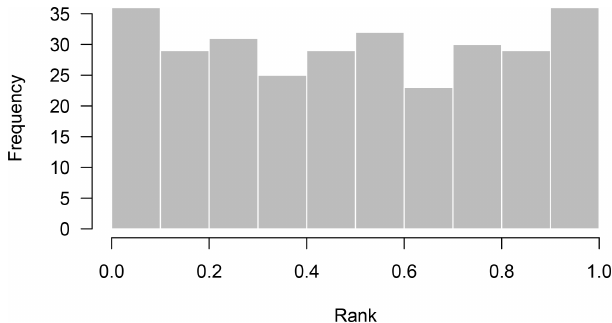
Figure 7. Rank histogram of leave-one-out predictions. For each prediction of a held-out ensemble member, we sample 1000 points from the Gaussian prediction distribution and then record where the true held-out ensemble member ranks in that distribution. We plot a histogram of the ranks for all 300 ensemble members. A uniform distribution of ranks indicates that uncertainty estimates of the em- ulator are well